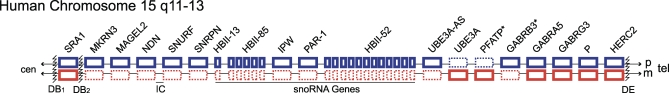
Human PWS/AS Cluster of Imprinted GenesThe colors red and blue represent the maternally and paternally inherited alleles. Continuous and dashed lines represent expressed and silent genes respectively.